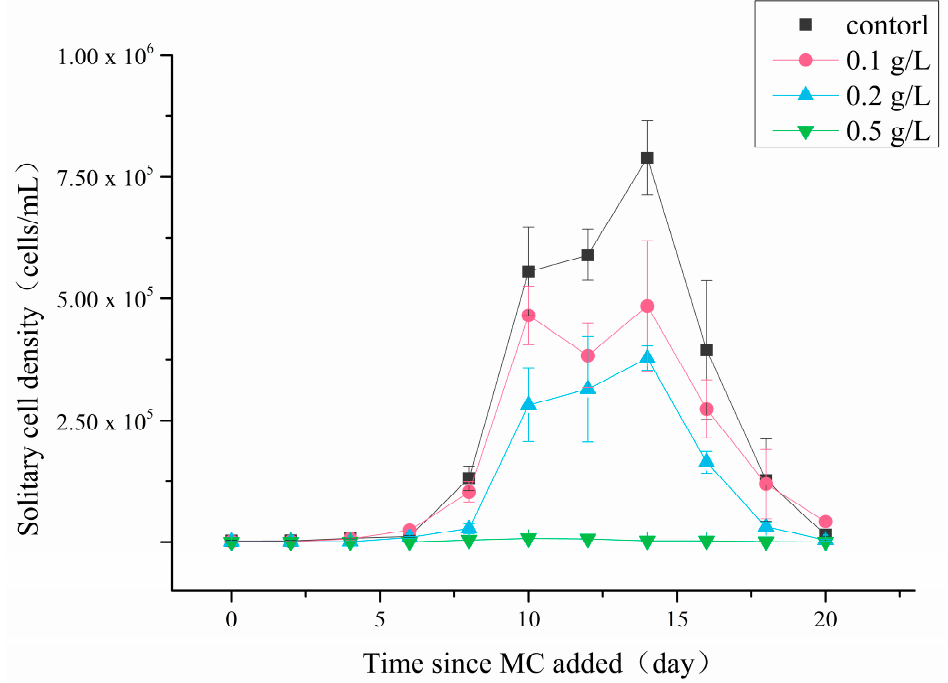
Figure 1. Changes in the density of P. globosa solitary cells after treatment with different concentrations of